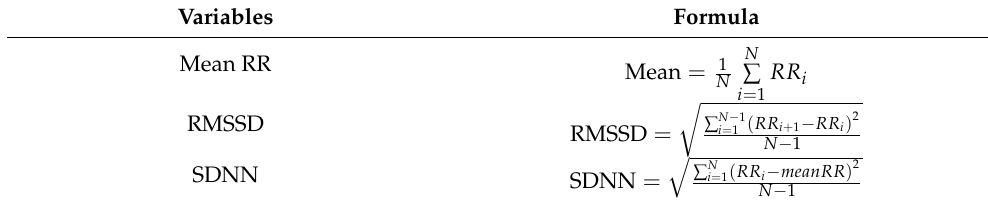
Table 1. Time domain HRV indices.